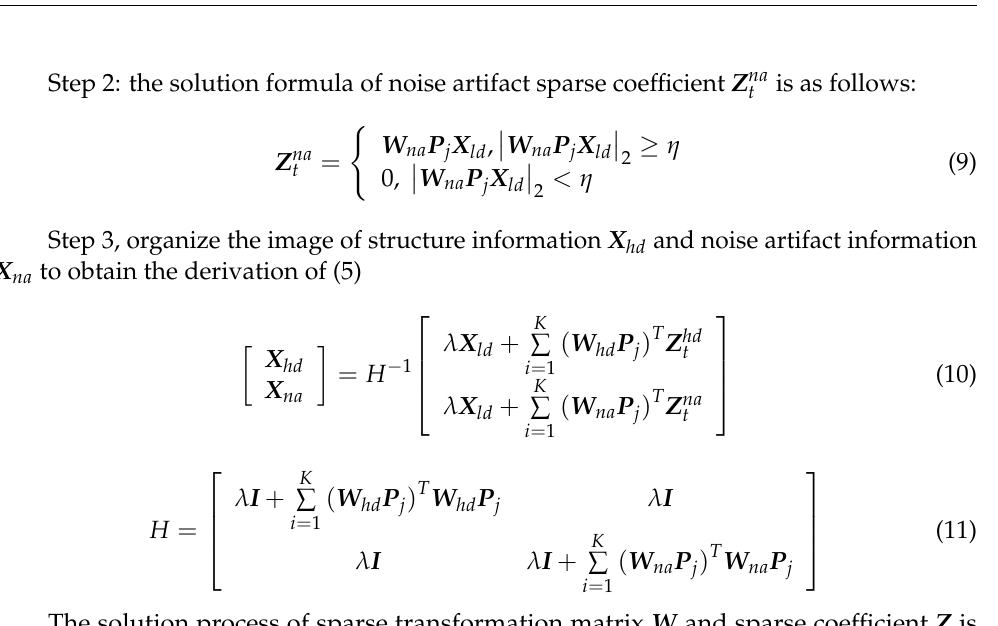
( b ) Figure 3. Training image. ( a ) Standard dose; ( b ) noise CT images. 3. Experiments and Results 3.1. Dataset and Experimental Environment This paper’s test data are low-dose CT images obtained by simulating the heart trunk phantom CT data’s fan-beam scanning scene [42–44]. This study used simulated images,